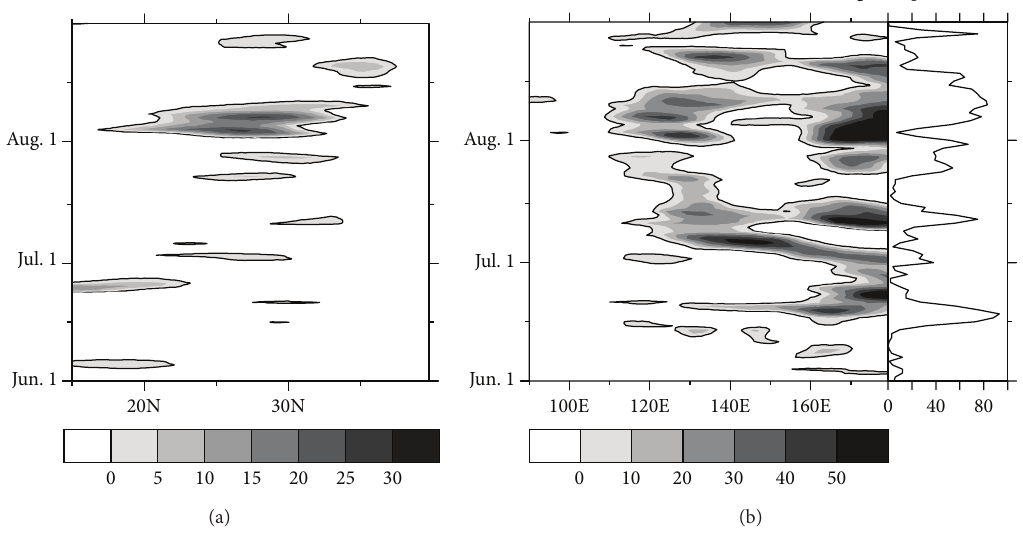
Figure 3: The 500 hPa geopotential height departure from 5880 gpm (shaded area, gpm) of (a) the time-latitude profile and (b) the time- longitude profile and stations affected by the heat wave in region A in the summer of 2013. In (b), the right figure denotes the number of daily total stations affected by the heat wave.